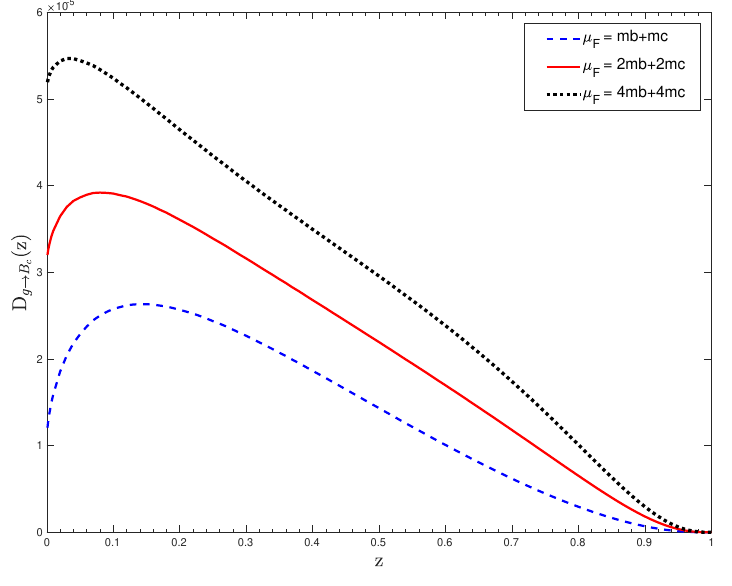
Figure 2 . The fragmentation function D g → B and µ F = 4 M , where the strong coupling constant is fixed as α s (2 m c ) = 0 . 259 .